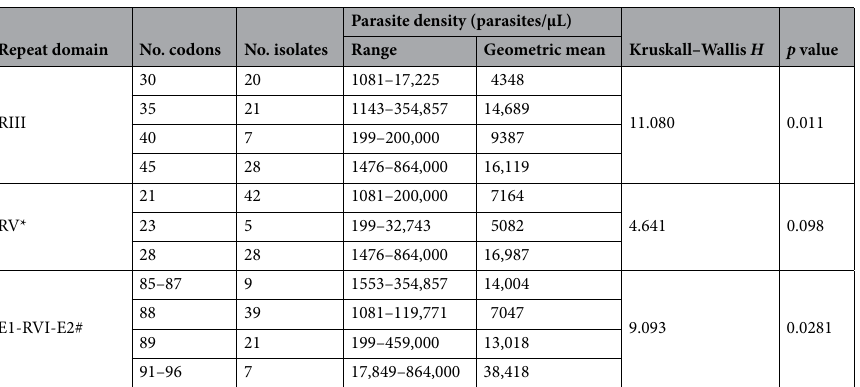
Table 7. Length polymorphism in repeat domains of PfGARP and parasite density. *One isolate containing 35 codons was omitted from analysis. # Repeats with number of isolates < 5 were combined due to extensive length polymorphism in repeat domain VI. Domains RI, RII and RIV were excluded due to insufficient categorical data.